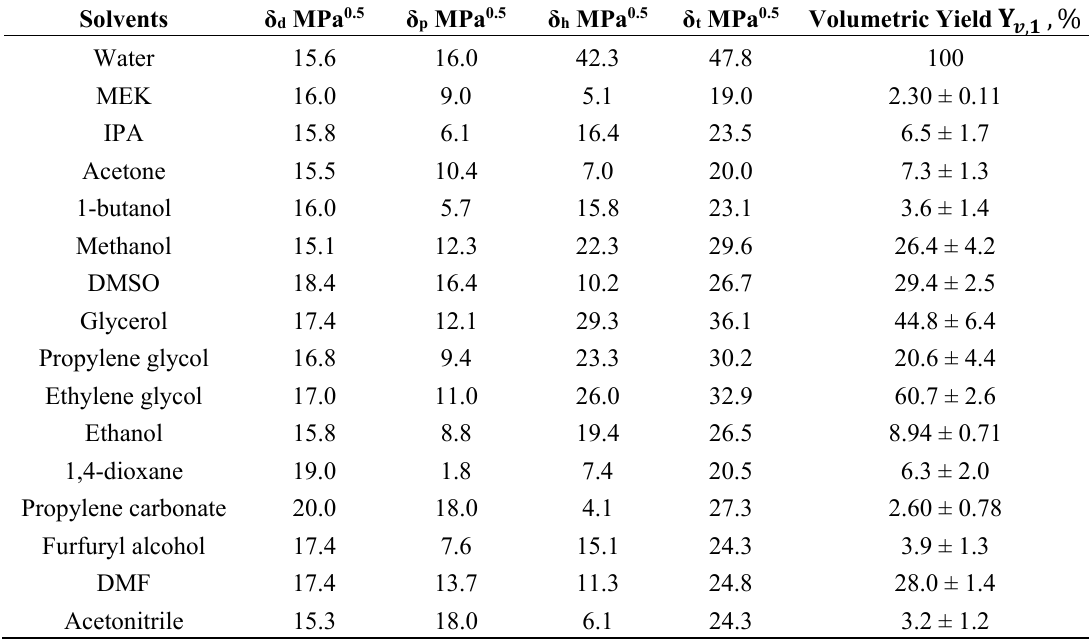
Table 1. The Hansen solubility parameters of solvents and experimentally measured volumetric yields after one step solvent